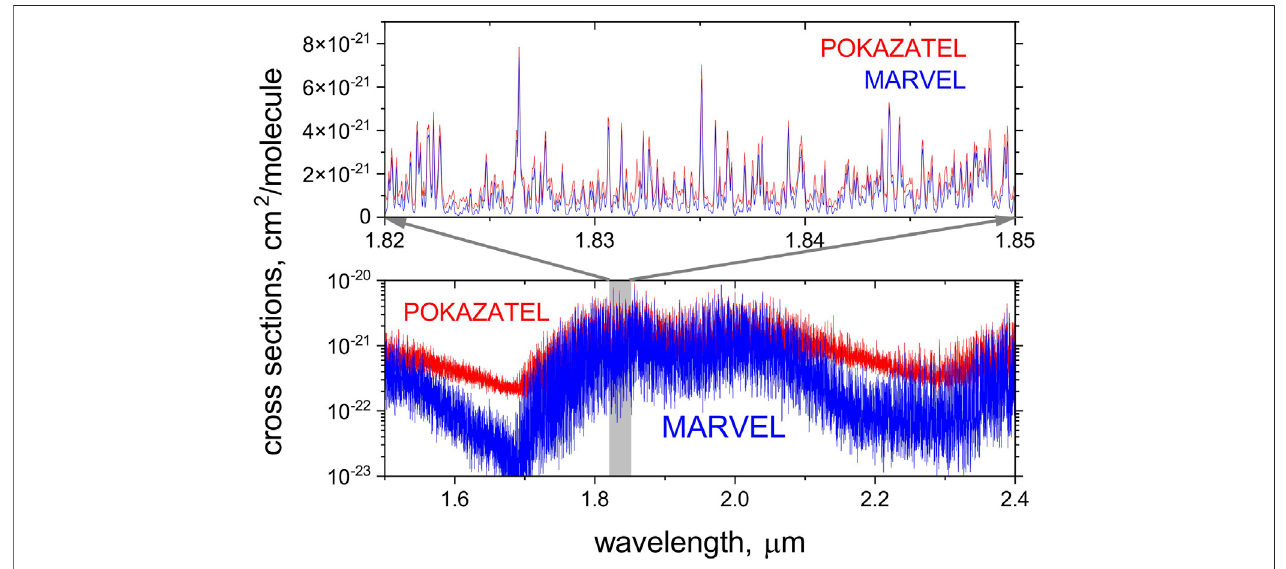
FIGURE 3 | Same as Figure 2 but at higher resolution ( R (cid:1) 45,000): contribution of MARVEL states to the spectra of H 16 2 O (MARVEL) compared to the full spectra (POKAZATEL) for high temperature, T (cid:1) 3000 K. In both cases the intensities are from the POKAZATEL line list (Polyansky et al., 2018). The cross sections were computed using the Voigt line pro fi le using the broadening parameters of H 2 O from the ExoMol diet (Barton et al., 2017).